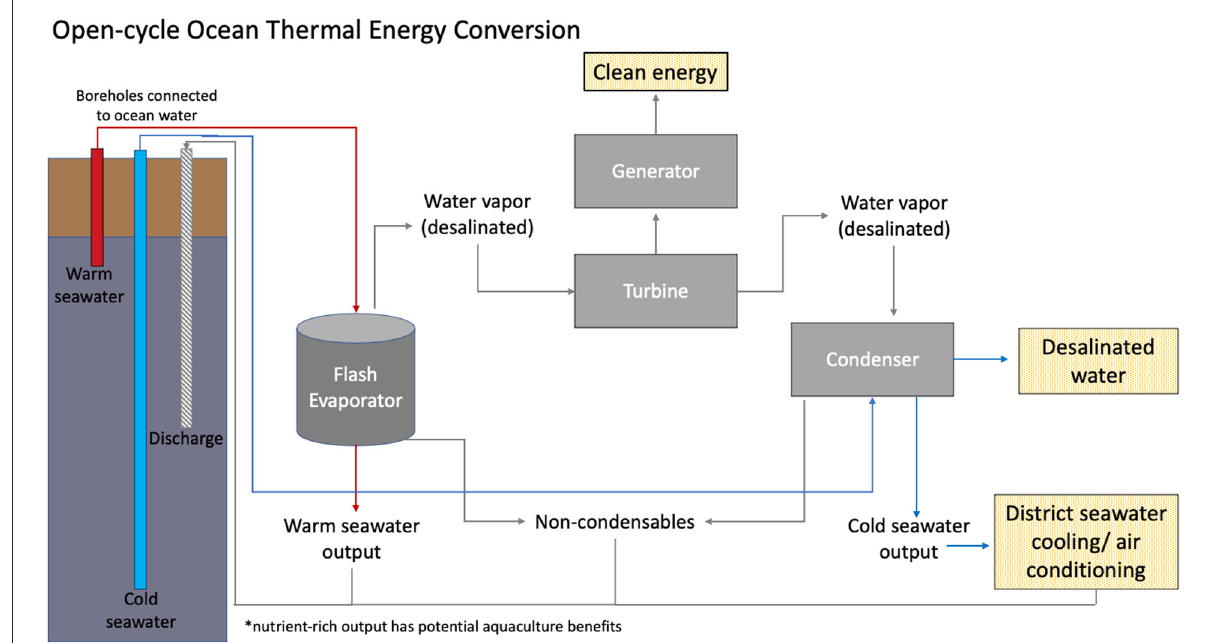
FIGURE3 Schematic of an open-cycle Ocean Thermal Energy Conversion using sea water sourced through boreholes. In this system, both energy and desalinated water are produced. Figure adapted from International Renewable Energy Agency [IRENA]